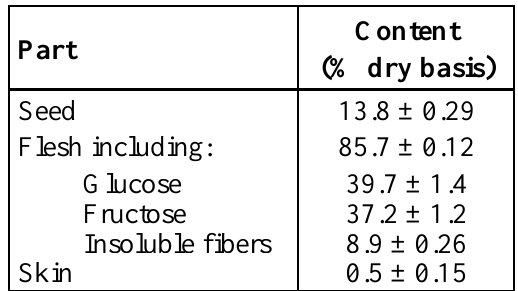
Table 1. Date palm fruit main parts.